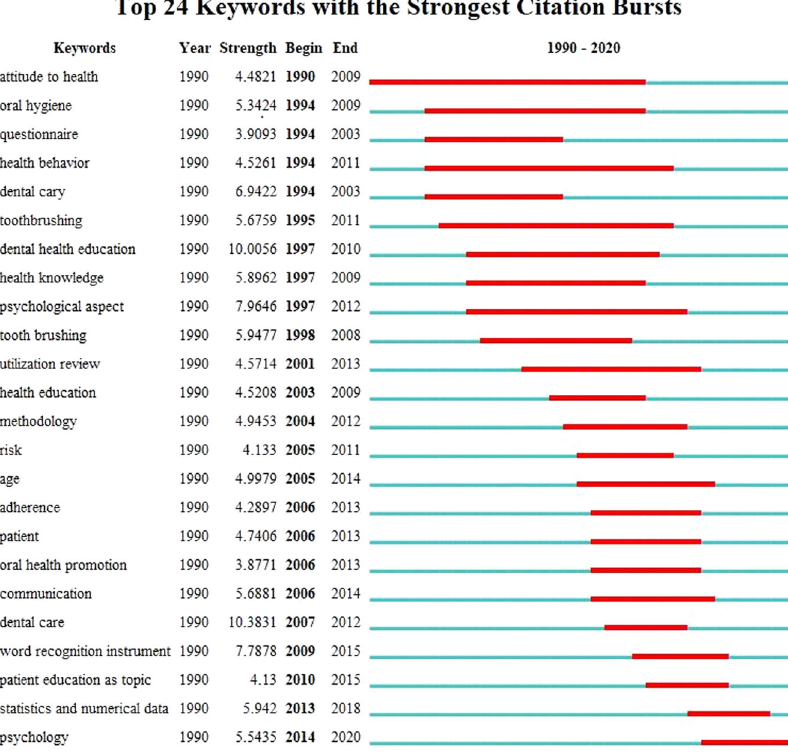
Fig. 9 The citation bursts of keywords. The keywords with strong citation bursts from publications in oral health literacy